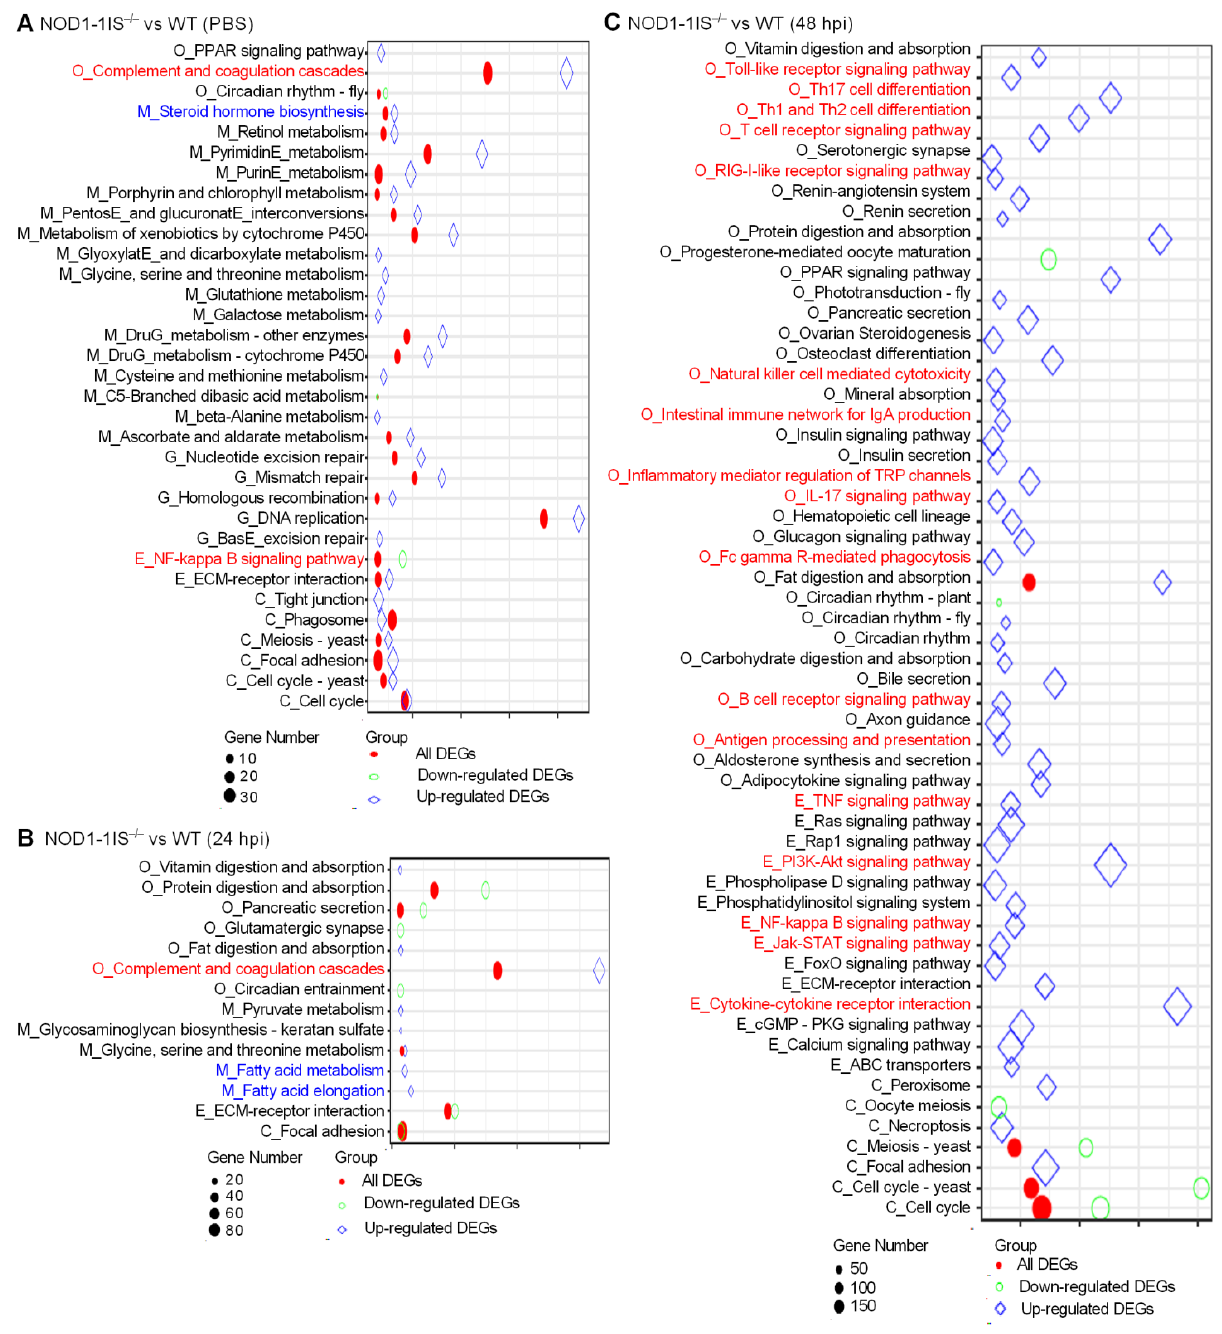
Figure 3. KEGG enrichment analysis. ( A ) The KEGG enrichment analysis for DEGs between WT and NOD1-deficiency zebrafish injected with the control PBS. ( B ) The KEGG enrichment analysis for DEGs between WT and NOD1-deficiency zebrafish infected with S. agalactiae for 24 h. ( C ) The KEGG enrichment analysis for DEGs between WT and NOD1-deficiency zebrafish infected with S. agalactiae for 48 h. All of the KEGG pathways shown in the figure are significantly enriched (Q-value < 0.05). The x -axis represents the rich factor, and the y -axis indicates the corresponding KEGG pathway. The immune-related pathways are red and the lipid-related pathways are blue. The color and shape of the point indicates the type of DEGs. The size of the point indicates the gene numbers.